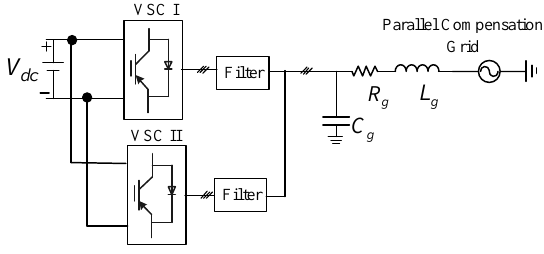
Figure 12. Structure of the multiple parallel units.